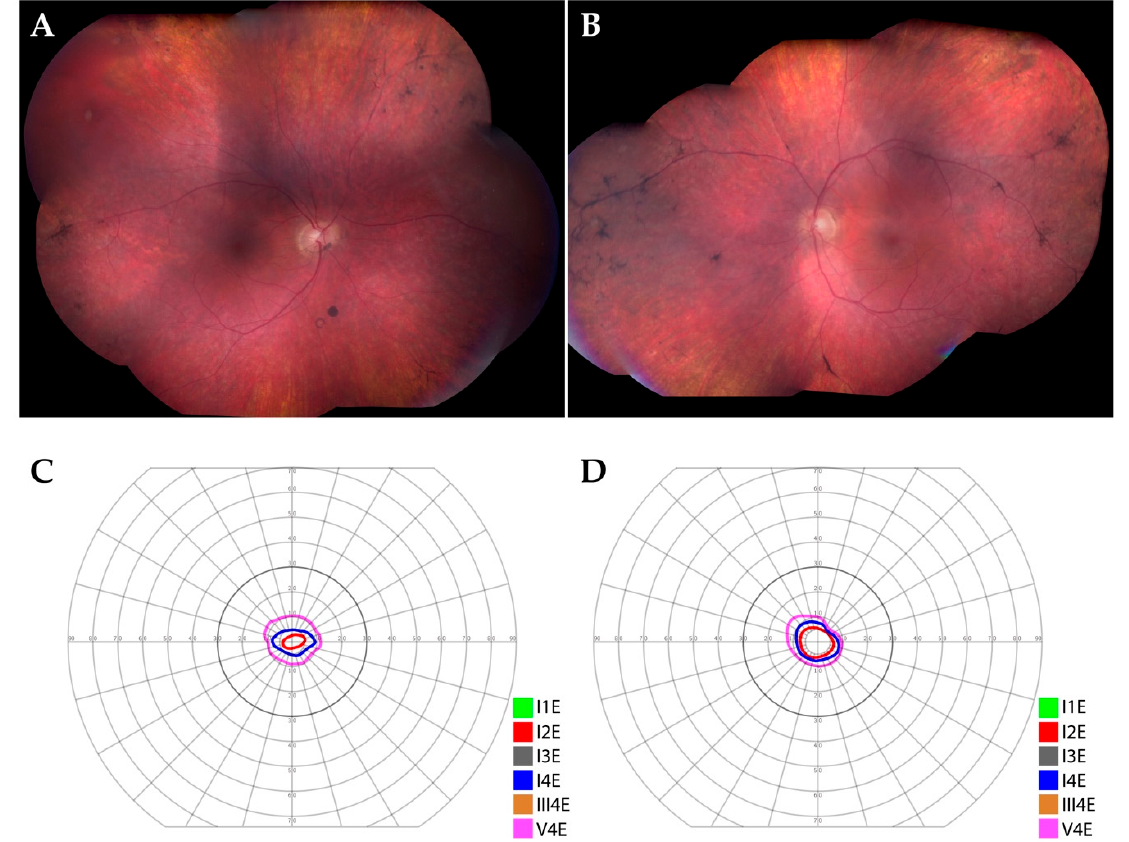
Figure 1. Clinical findings in a patient with retinal degeneration. ( A , B ): Montage color fundus photographs of the right ( A ) and left ( B ) eyes. There was granular, retinal pigment epithelial atrophy in the mid-periphery of both eyes, in addition to peripheral bone-spicule-like pigmentary changes and pigment clumps in both eyes. Arteriolar attenuation was notable in both eyes. ( C , D ): Goldman visual fields of the right ( C ) and left ( D ) eyes. There was severe constriction of the peripheral visual field in both eyes.